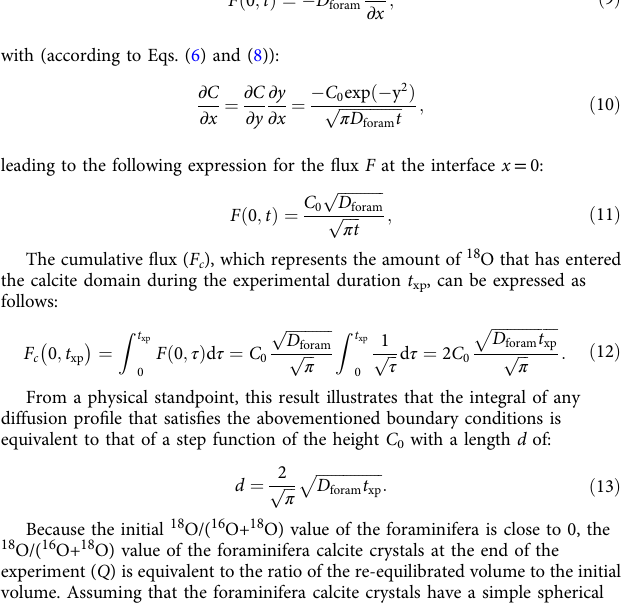
ffiffiffiffiffiffiffiffiffiffiffiffiffiffiffiffiffi D foram t xp